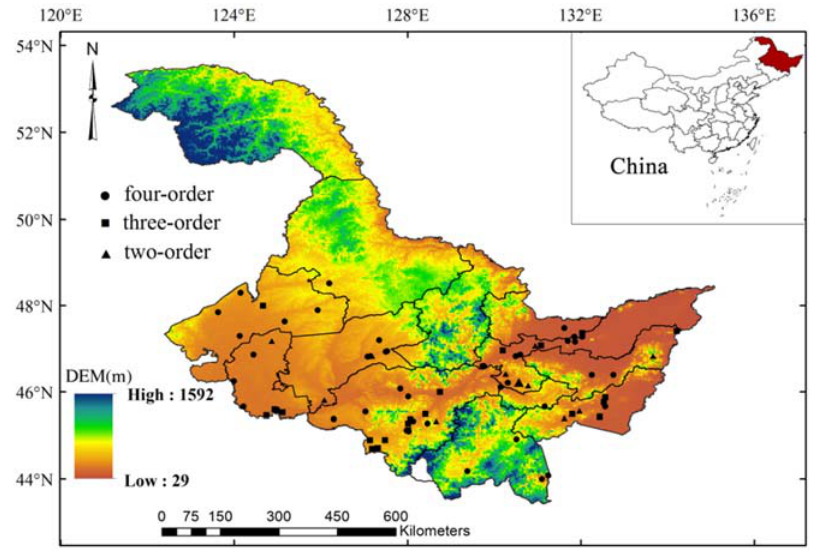
Figure 1. Distribution map of the irrigation area studied in Heilongjiang Province.